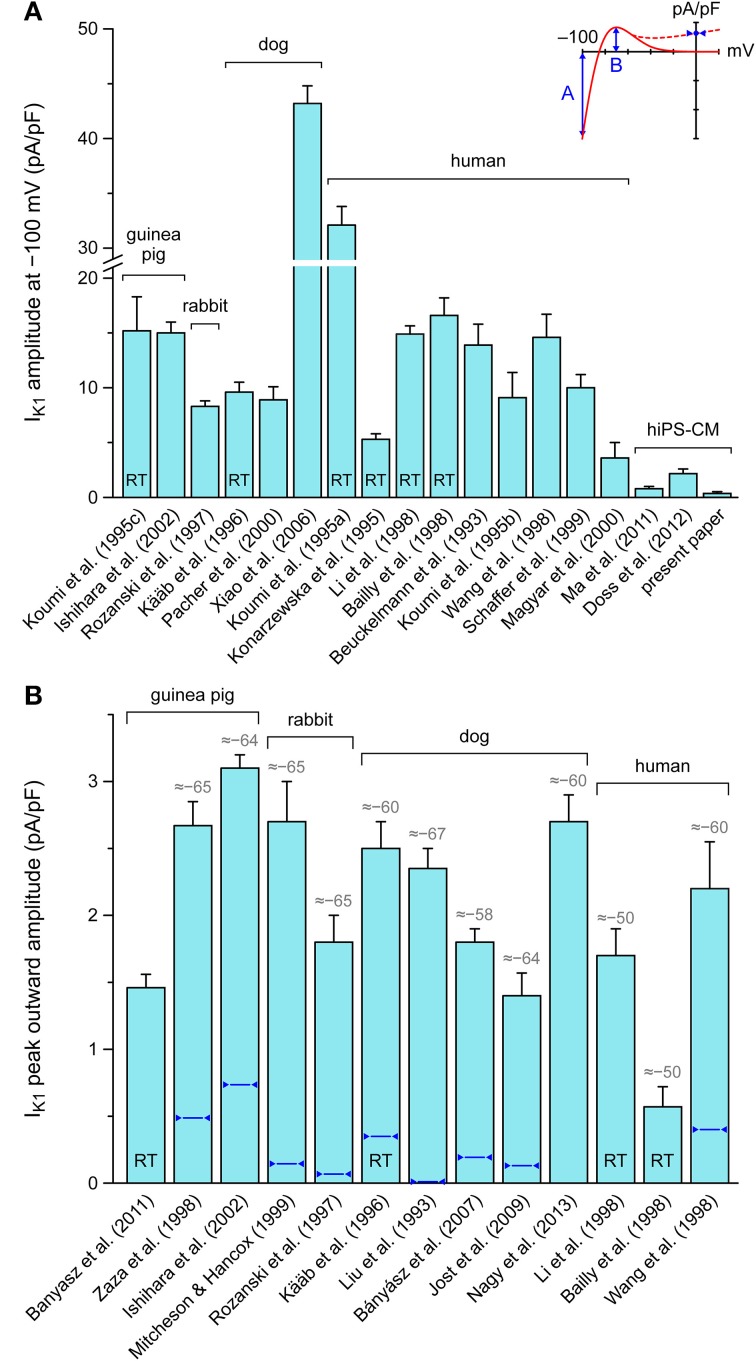
Amplitude of inward rectifier potassium current (IK1) in mammalian ventricular myocytes and human induced pluripotent stem cell derived cardiomyocytes (hiPSC-CMs). (A) Amplitude of IK1 at a membrane potential of −100 mV. Note axis break. (B) Amplitude of peak outward IK1. Inset illustrates current-voltage relationship of IK1 with values shown in panels A and B. Data are mean ± SEM obtained at room temperature (bars labeled “RT”) or at physiological or close-to-physiological temperature. If data are available, numbers in gray above bars in (B) indicate the membrane potential (in mV) at which the peak outward amplitude is reached, whereas dark blue triangles indicate the approximate amplitude at 0 mV. Some data are estimated from graphs.